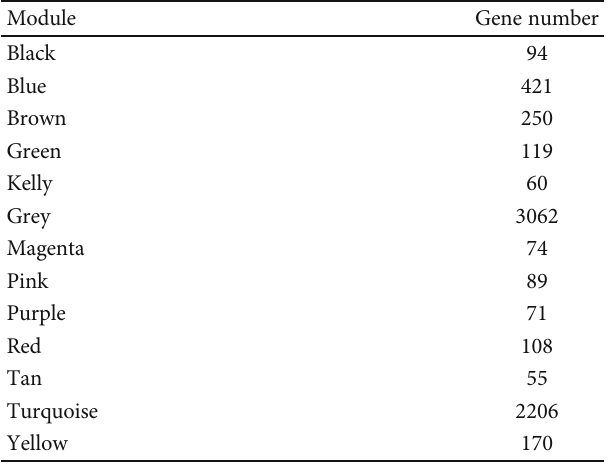
Table 2: Gene numbers of each module in